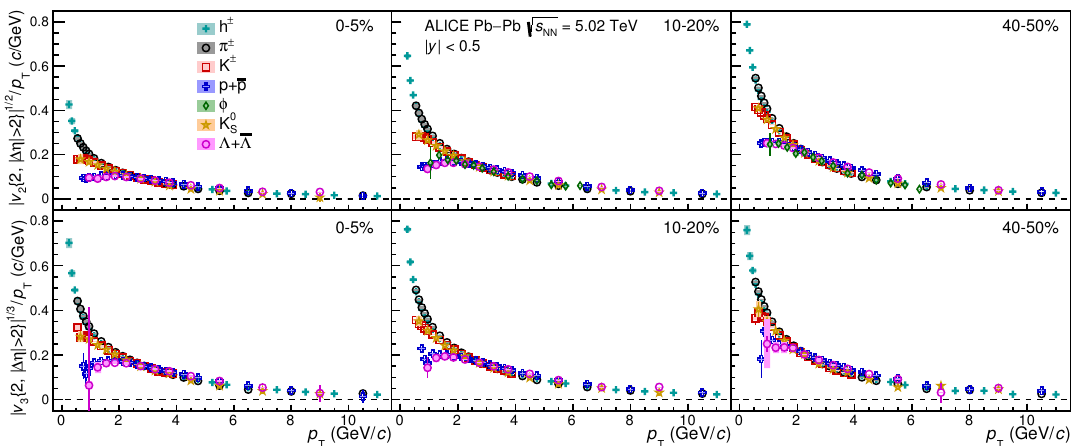
Figure 19 . (Colour online) Centrality dependence of j v n j 1 = n =p T of inclusive charged particles [44], (cid:25) (cid:6) , K (cid:6) , p+p, (cid:3)+(cid:3), K 0 , and the (cid:30) -meson for n = 2 (upper panels) and n = 3 (lower panels). S Statistical and systematic uncertainties are shown as bars and boxes,